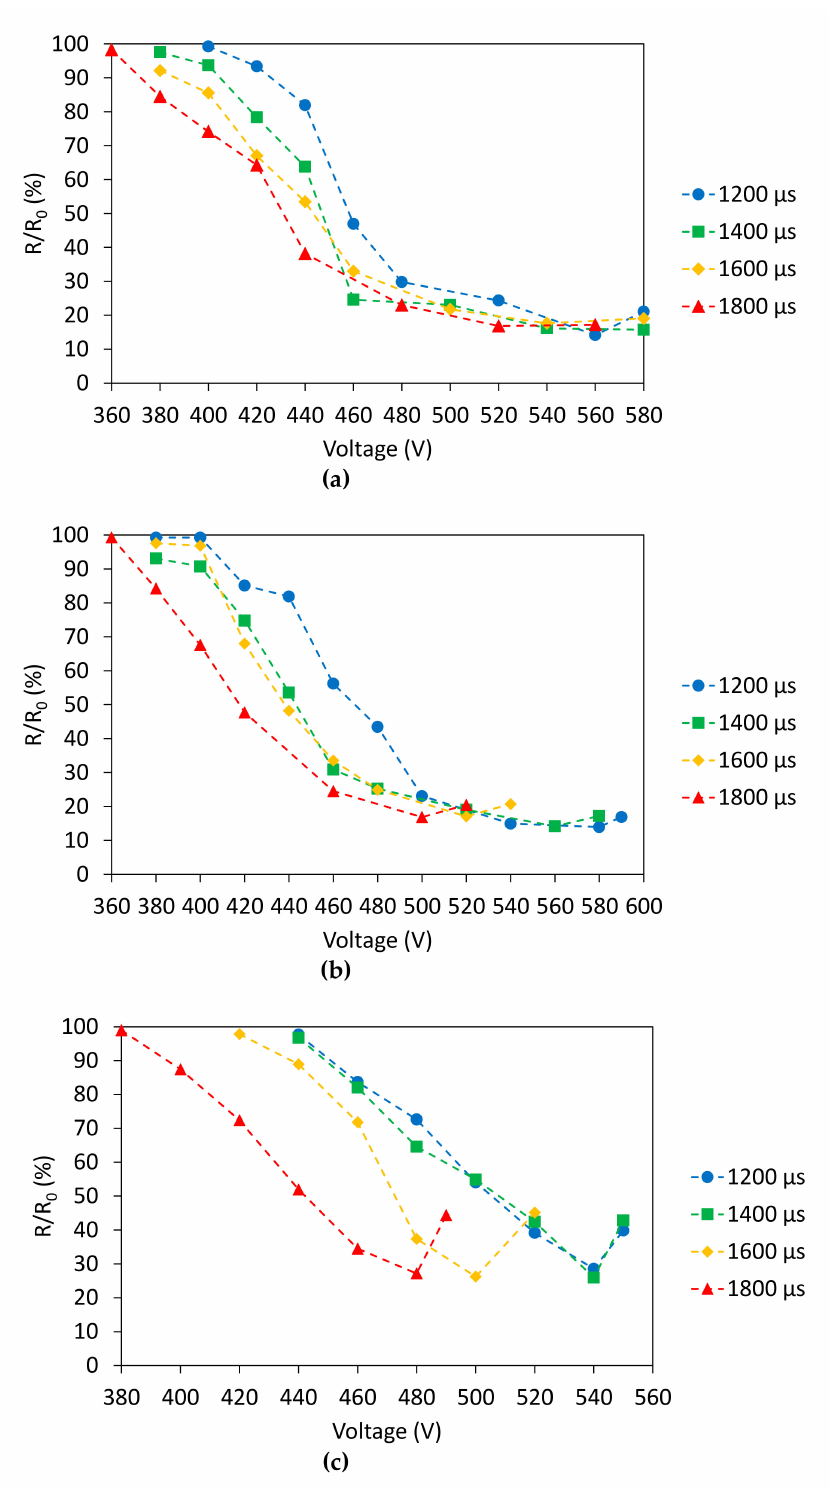
Figure 3. R / R 0 vs. voltage depending on impulse duration for ( a ) chromatographic paper, ( b ) cardboard, and ( c )